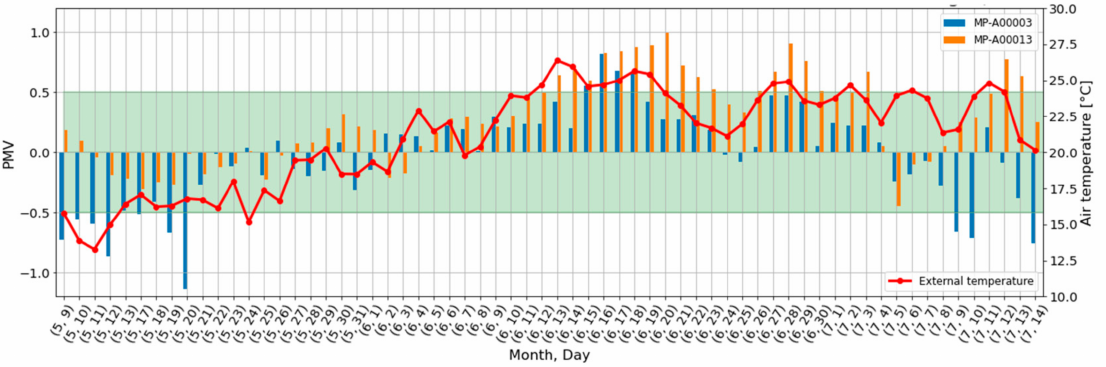
Figure 15. Daily distribution of PMV for MP-A00003 and MP-A00013, and external